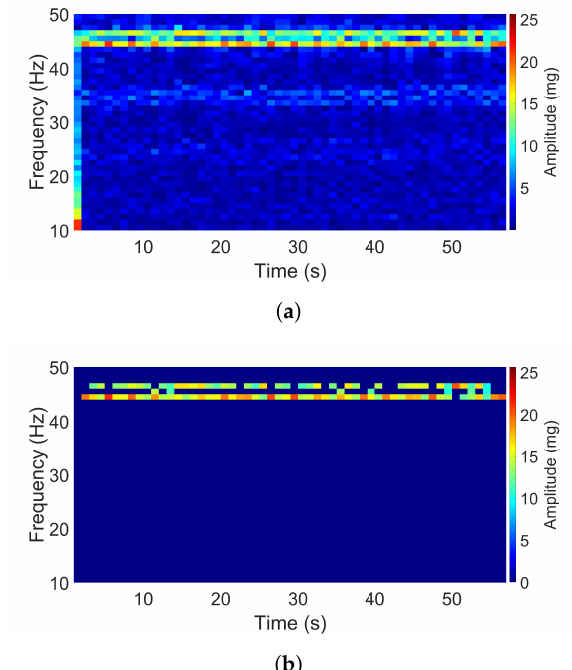
Figure 9. Spectrogram of the aquarium signal (Z direction): ( a ) Original. ( b )